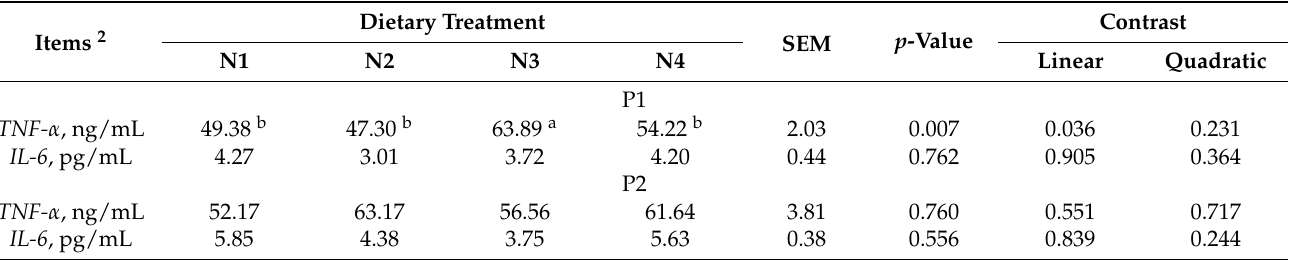
Table 6. The cytokines production in jejunal mucosa of weaned piglets with different niacin concentrations 1